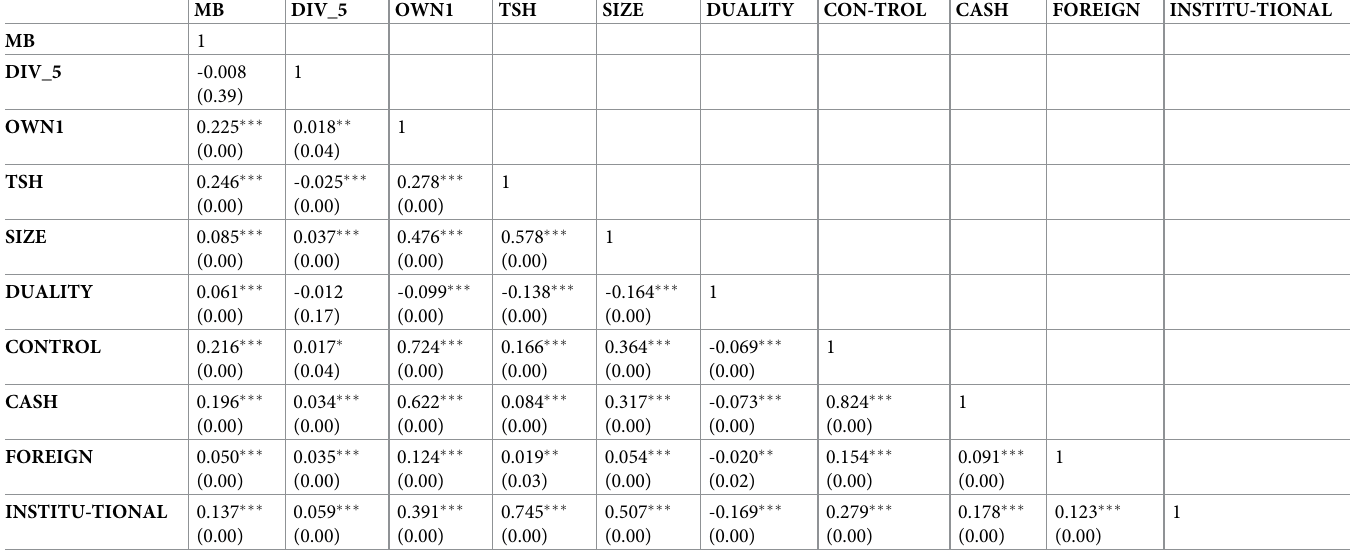
Table 2. Correlation